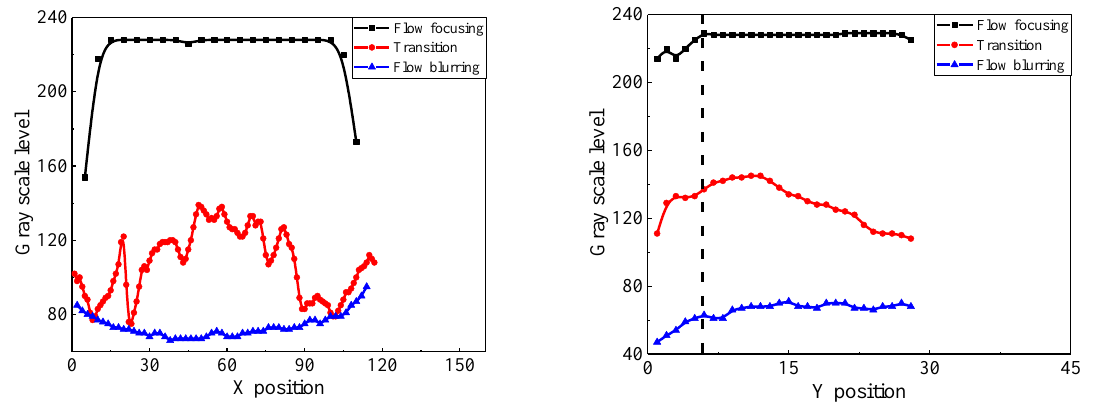
( b ) Axial gray scale distribution of flow field Figure 14. Gray scale distribution of local flow field.